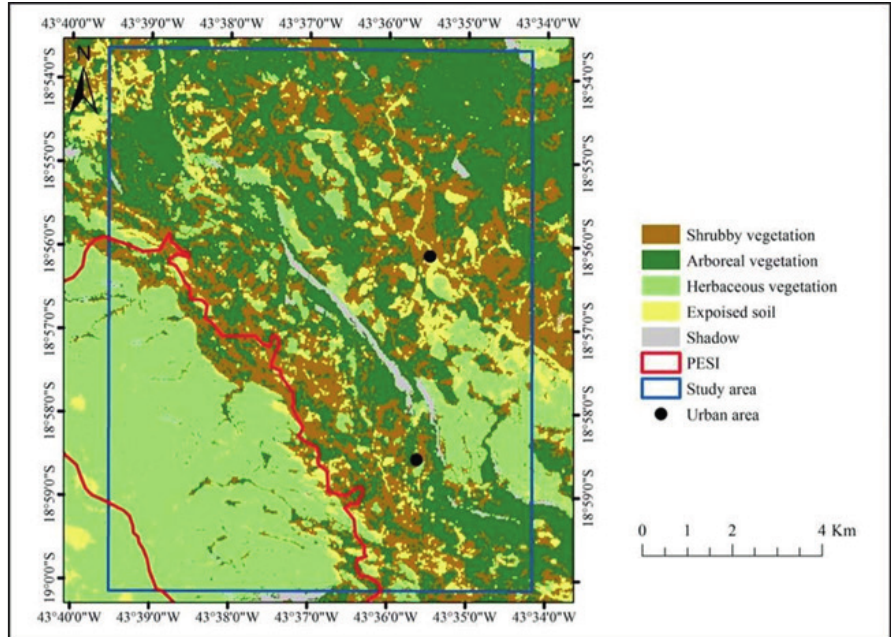
Figure 3 - Use and occupation of the soil in the study area in the year